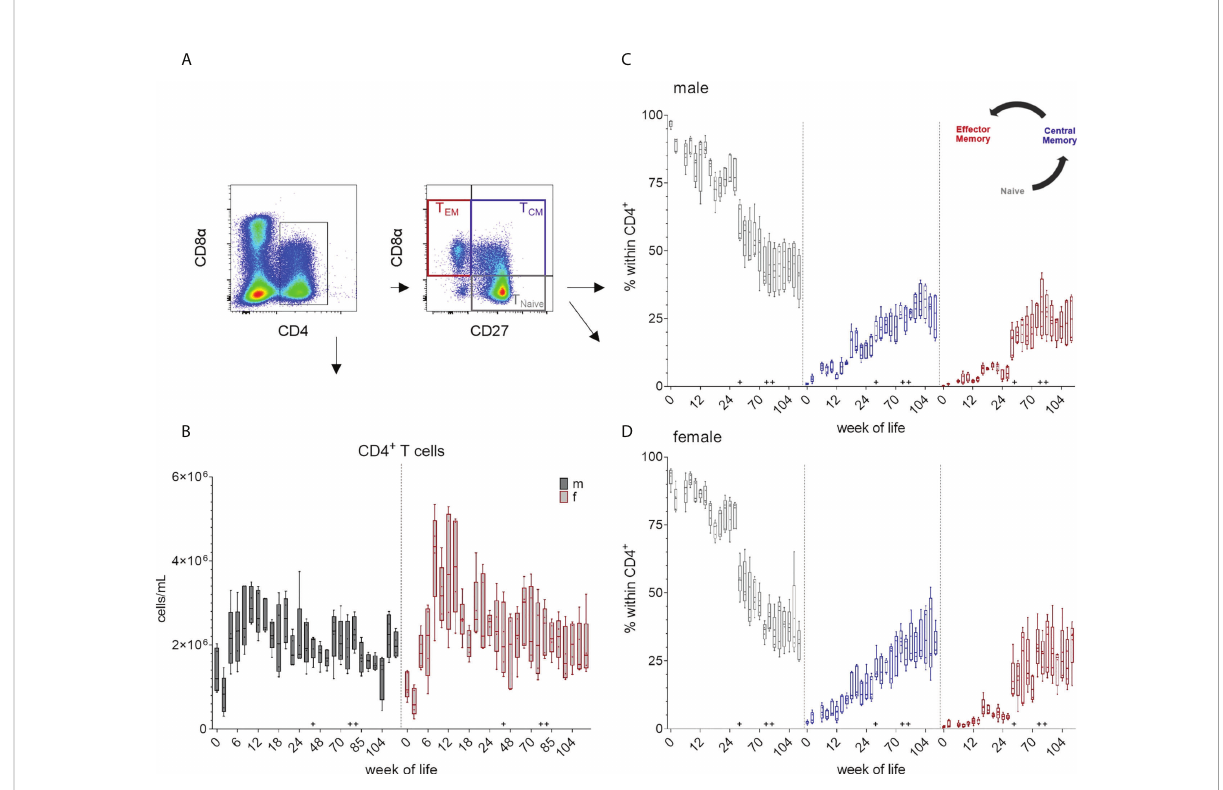
FIGURE 7 Total numbers of CD4 + T cells and the development of T CM and T EM CD4 + cells over a study period of 126 weeks. (A) Gating strategy to distinguish CD4 T cells and CD8 a /CD27-de fi ned subpopulations on the basis of a representative EGM (male, 18 weeks of age). (B) Shows the total CD4 + T cell counts calculated as described above. Sexes are represented by black (male) and red colors (female). (C, D) Changes in the composition of the CD4/CD8 a /CD27-de fi ned T cell subsets representing T Naive (CD4 + CD8 a - CD27 + ), activated and T CM (CD4 + CD8 a + CD27 + ) and T EM (CD4 + CD8 a + CD27 - ) in males (C) and females (D) . + marks the fi rst bleeding time point after transfer and vaccination, ++ marks the fi rst bleeding time point after booster